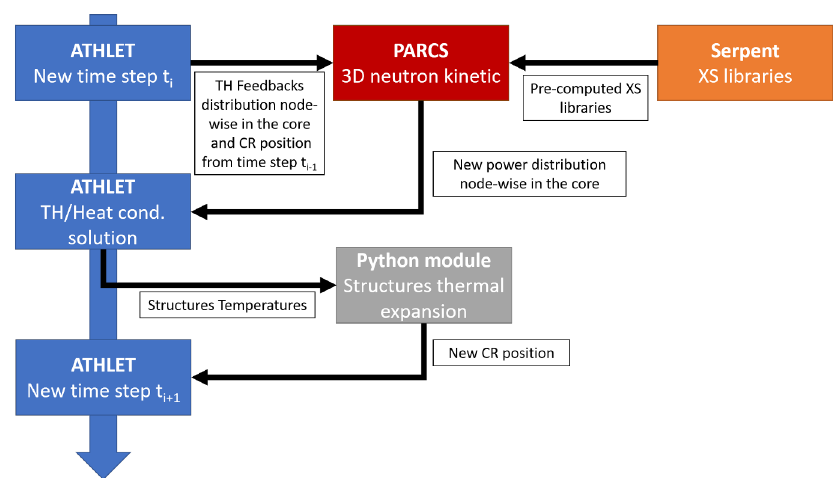
Figure 2: Diagram of calculation process during one time step.